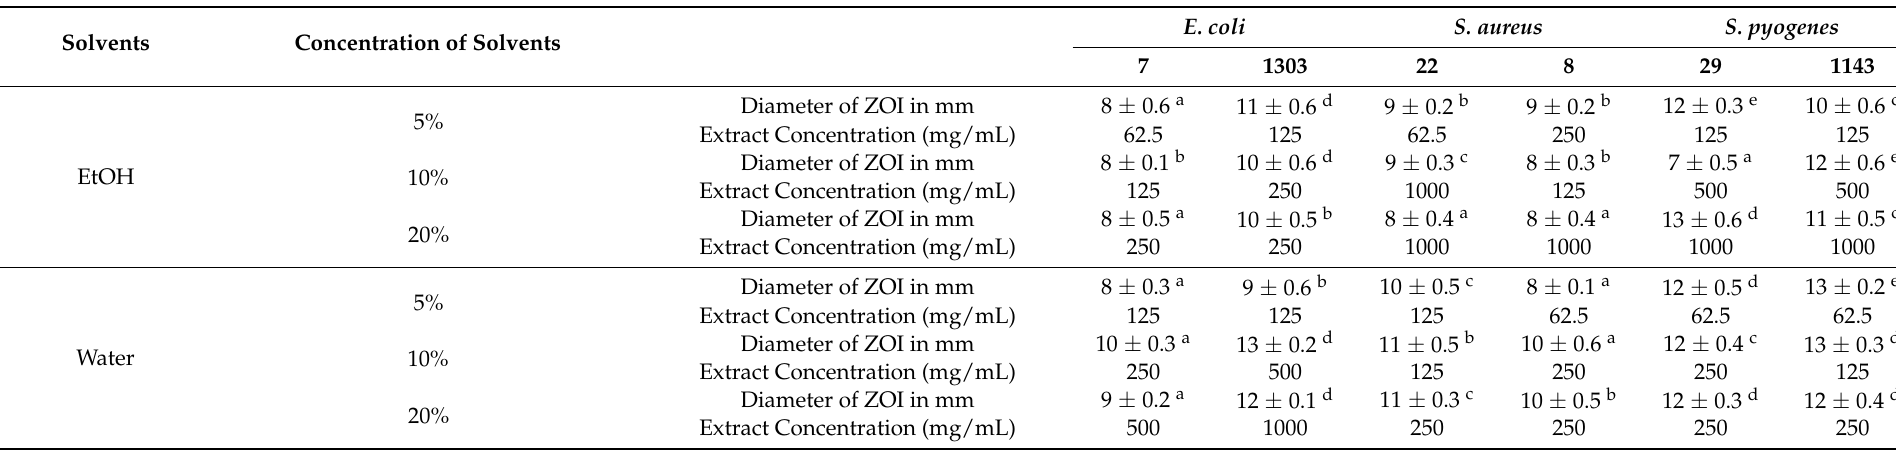
Different superscript letters in a row indicate statistically significant differences (ANOVA, LSD). Table 2. Zones of inhibition (ZOIs) of black chokeberry extract against Escherichia coli , Staphylococcus aureus , and Streptococcus pyogenes